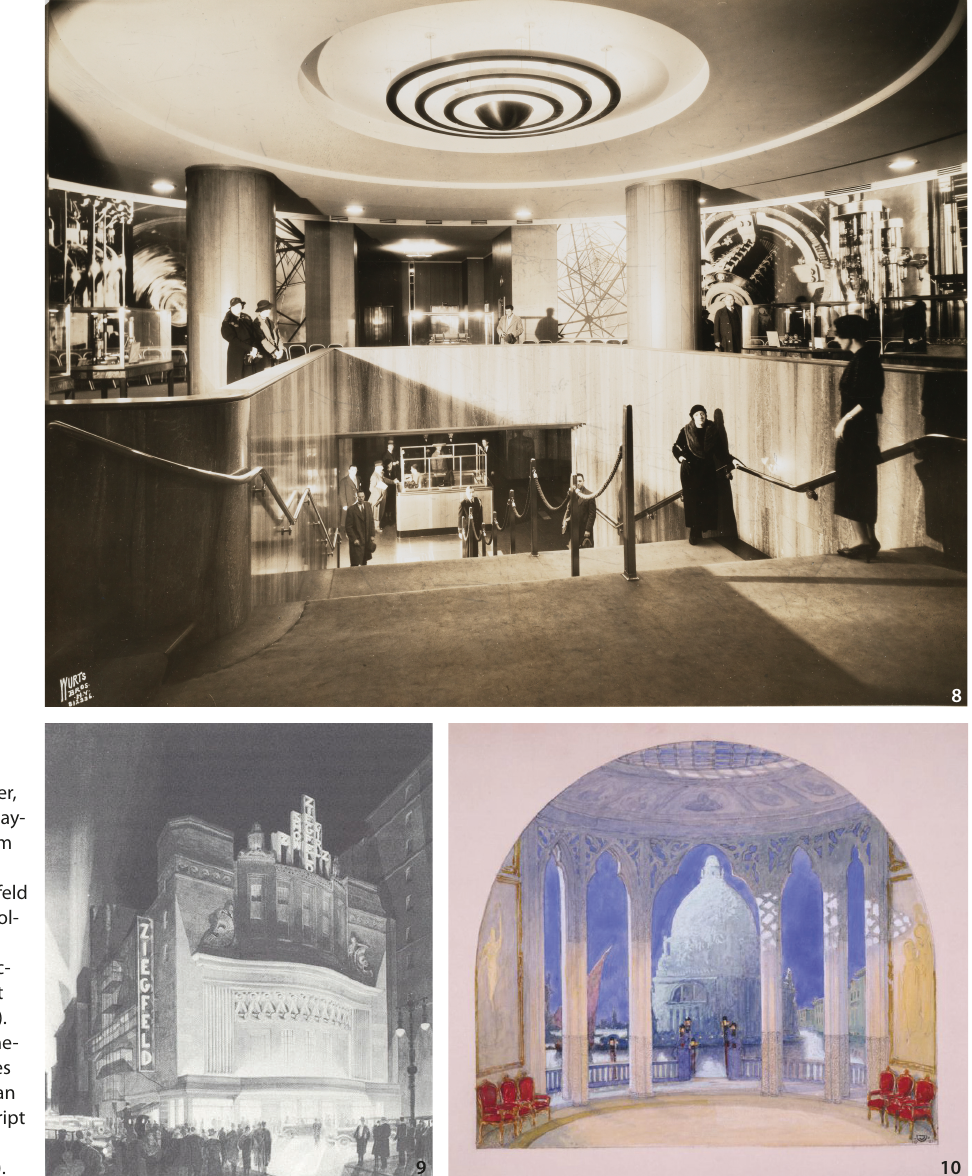
Figure 8 30 Rockefeller Center, Television Studio, architect Ray- mond Hood (Source: Museum of the City of New York). Figure 9 Joseph Urban, Ziegfeld Theater, Street Front, Watercol- our, New York, 1926–1927 (Source: Joseph Urban Collec- tion, Rare Book & Manuscript Library, Columbia University). Figure 10 Joseph Urban, Vene- tian Stage Set, Ziegfeld